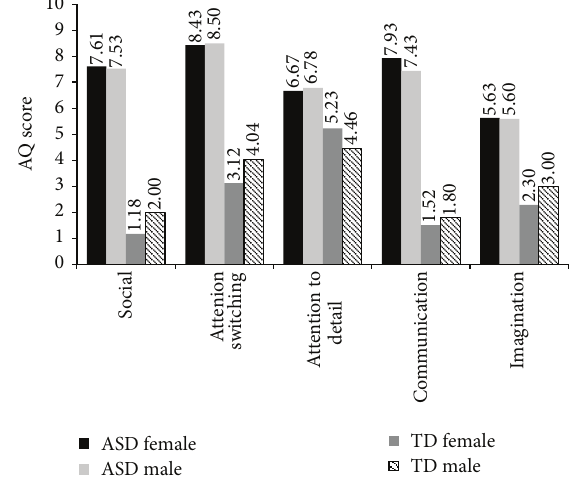
Figure 4: Mean scores on the AQ subscale scores for males and females of TD and ASD